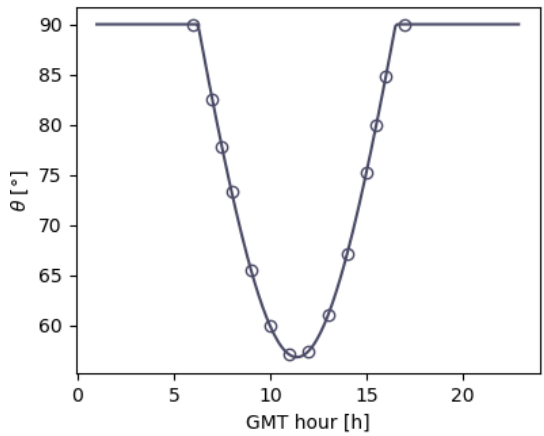
Figure 5. Zenith angle θ as a function of the hour of the day on 27 October at latitude 43.41 ◦ and longitude 5.06 ◦ (Martigues area). The (cid:13) symbols denote the hours of the J i measurements by the